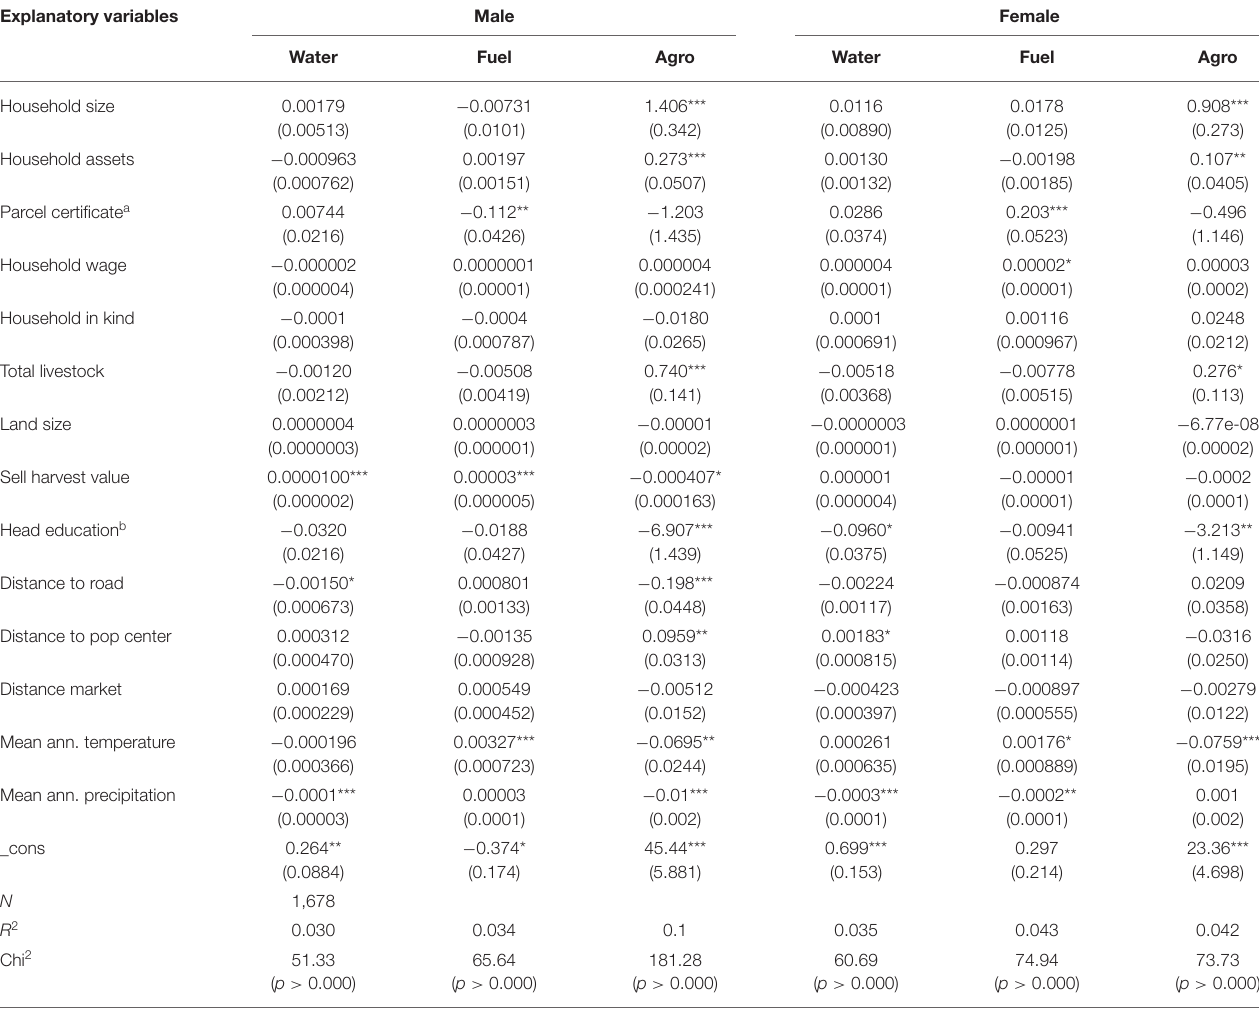
TABLE 5 | Seemingly unrelated regression result of labor hour allocated to different activities by gender groups. Explanatory